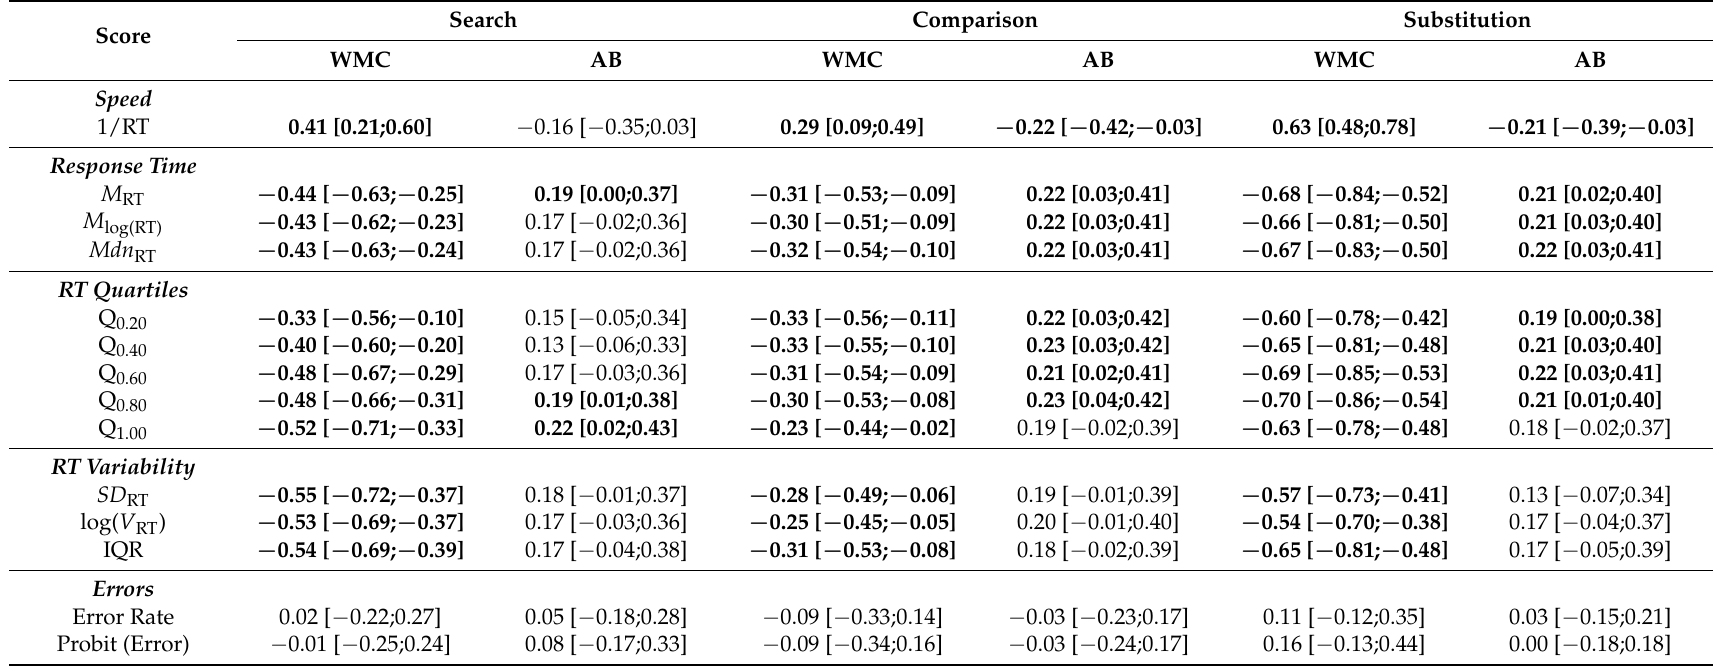
Table 3. Correlations of latent mental speed task-specific factors with WMC and